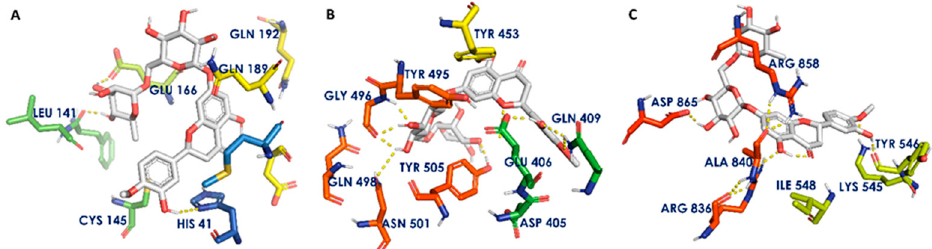
Figure 2. Receptor ‒ ligand interaction diagrams. ( A – C ): Interaction of hesperidin with the active sites of Mpro, spike-ACE2 RBD and RdRp, respectively. Gray sticks indicate ligands, atom-type color sticks indicate amino acid residues of receptor and yellow dotted lines represent hydrogen bonds formed between ligands and receptors.